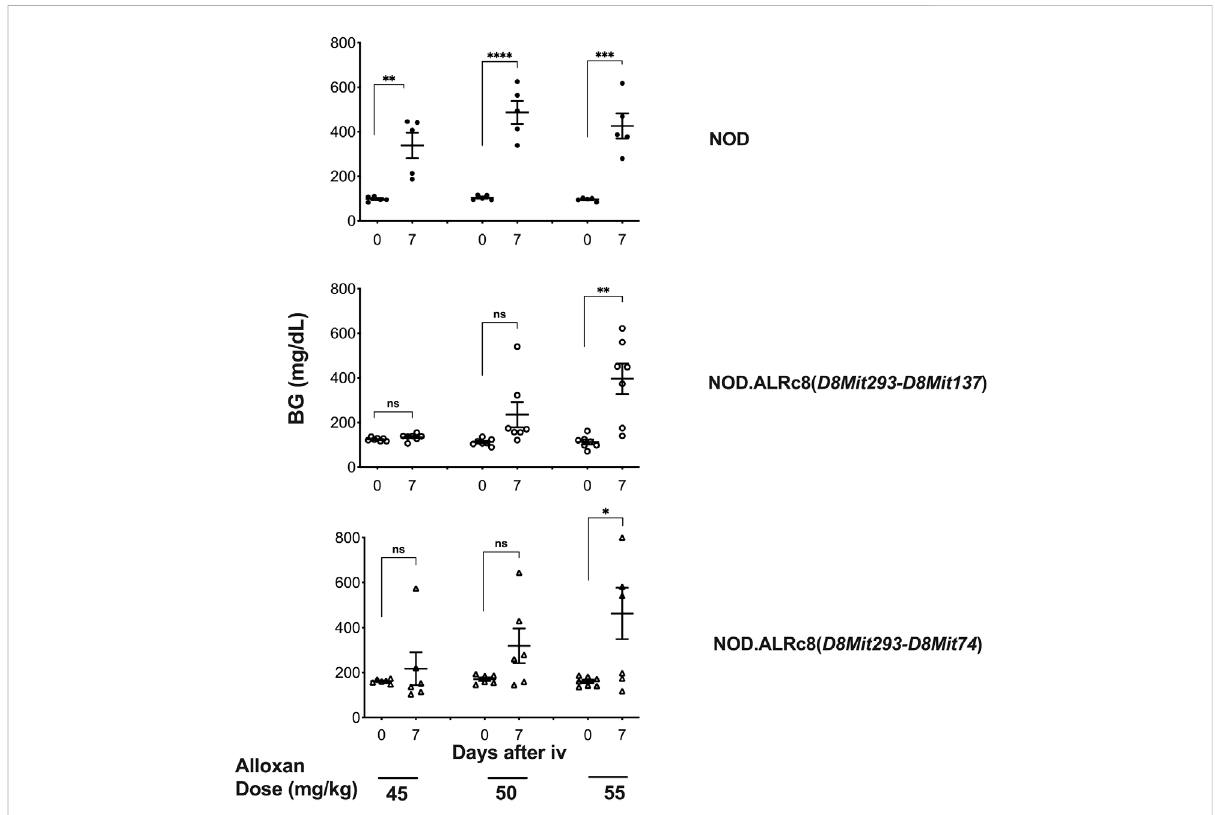
FIGURE 3 Mice congenic for ALR on chromosome 8 with short and long congenic regions show the same resistance to alloxan. Six-week-old male mice were challenged with different doses of alloxan as indicated. Blood glucose were measured before and 7 days after alloxan treatment. Upper panel: NOD control; middle panel: NOD. ALRc8 ( D8Mit293-D8Mit137 ); lower panel: NOD. ALRc8 ( D8Mit293-D8Mit74 ). n = 5 – 7. Unpaired t test. * p < 0.05; ** p < 0.01; *** p < 0.001; **** p <